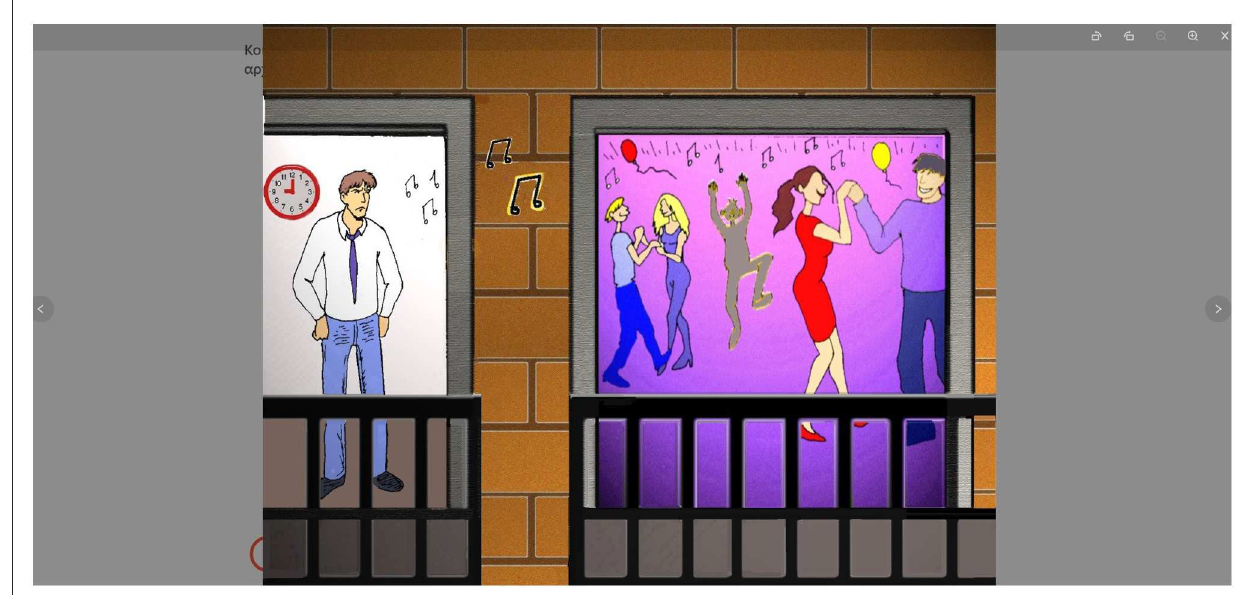
FIGURE2 Picture enlarging functionality of the Party task (picture adopted from the Kakavoulia et al., 2014